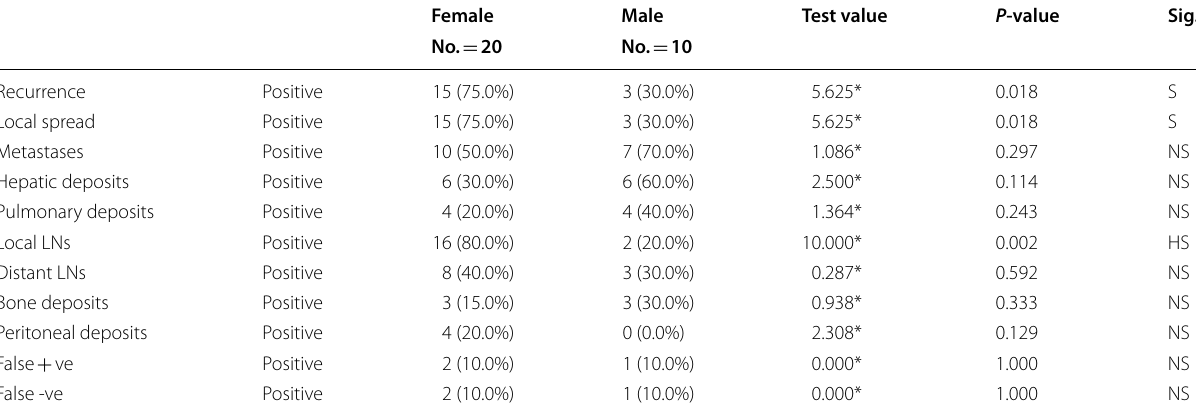
Table 3 Relation of gender of the studied patients with PET-CT findings in follow up patients with colorectal carcinoma after adjuvant